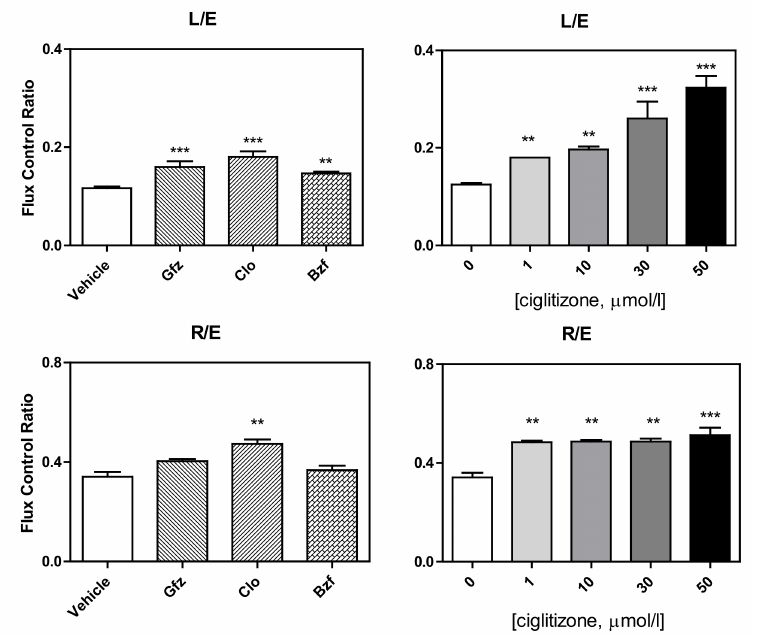
Figure 7. Respiratory control ratios. LEAK flux control ratios, L/E (ratio of oligomycin-inhibited and non-coupled respiration) and ROUTINE flux control ratios, R/E (ratio of ROUTINE and non-coupled respiration) of the HepG2 cells treated with different PPAR ligands ( on the left ) and with increasing concentrations of ciglitizone ( on the right ) (** p < 0.01 and *** p <